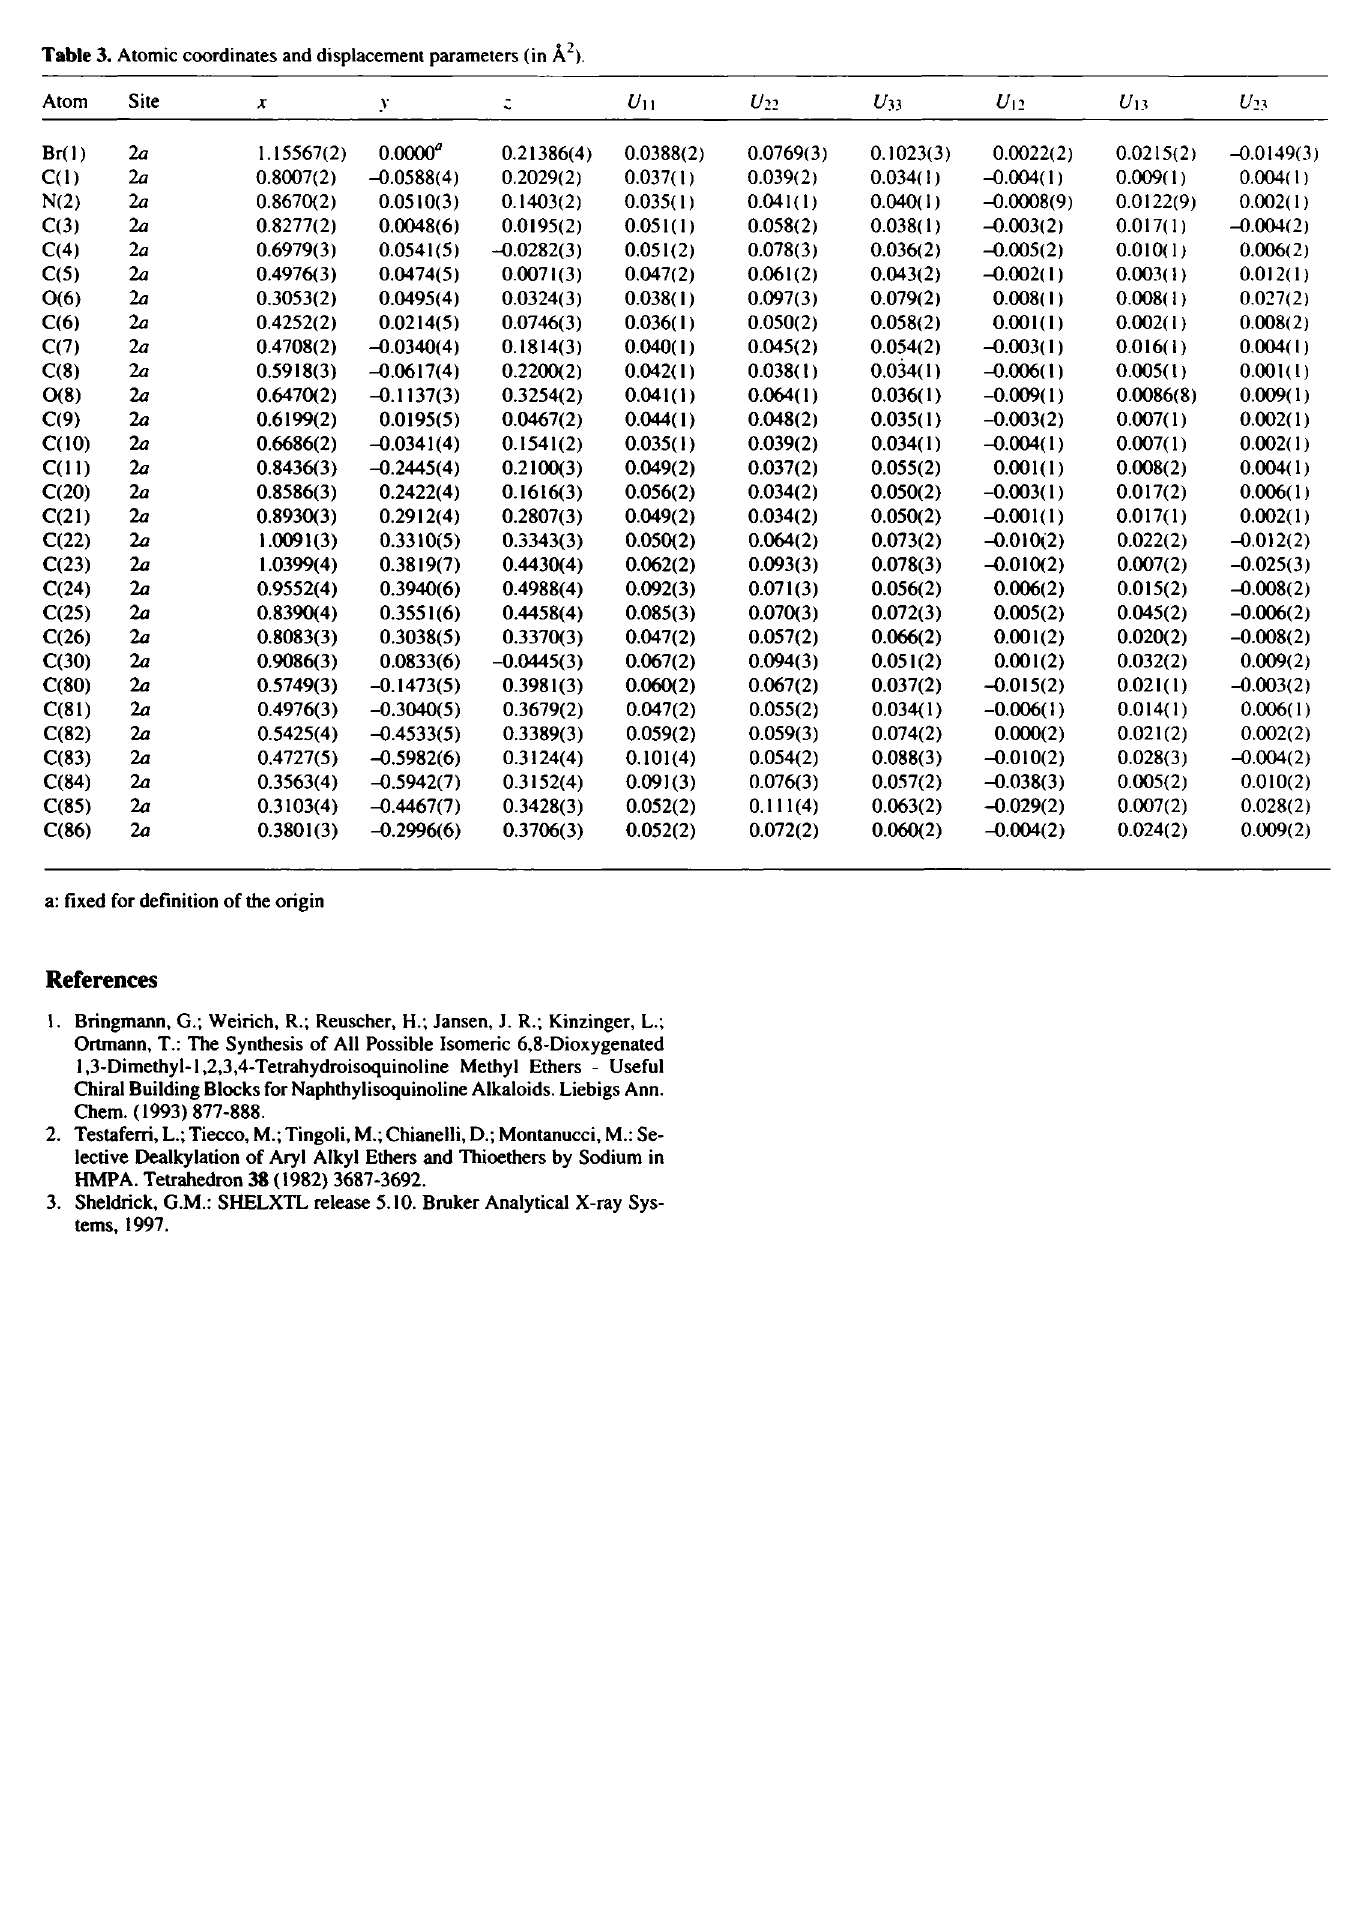
Table 3. Atomic coordinates and displacement parameters (in Ä 2